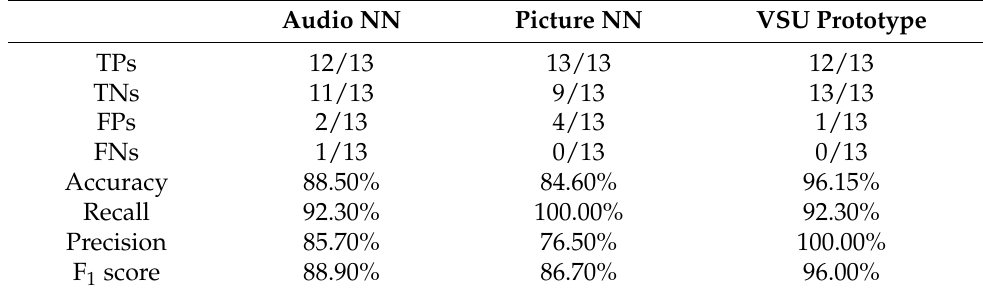
Figure 9. VSU prototype results on the test video. The green areas represent input samples belonging to the “No-Fire” class. The yellow, pink, and grey areas represent input samples belonging to the “Fire” class in LNT, MNT, and ENT, respectively. The solid blue line stands for the trend of p ( f ) , the dash-dotted line represents th A ∗ , and the dashed line represents th P ∗ . Finally, the vertical red lines mark the instants at which the VSU prototype signalled a fire alarm. Table 7. Test video results for the VSU prototype compared with the results of the audio NN and picture NN models